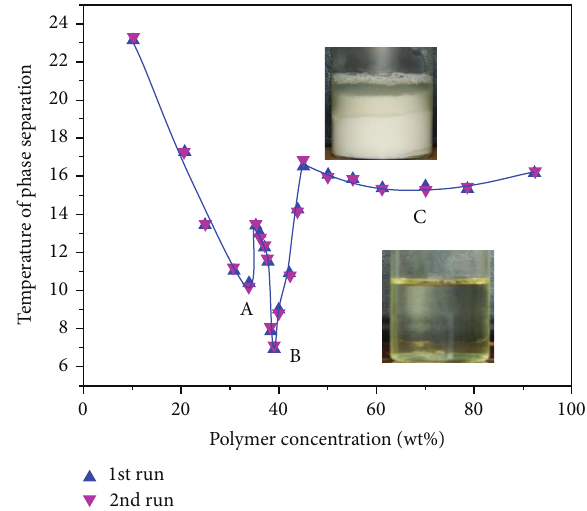
Figure5:PhasediagramoflinearPNIPA/watersystem;onsetvalues of LCST were taken from the TM-DSC plots (reversing heat flow) upon first and second heating at 5 ∘ C/min; lines are guides for the eye.